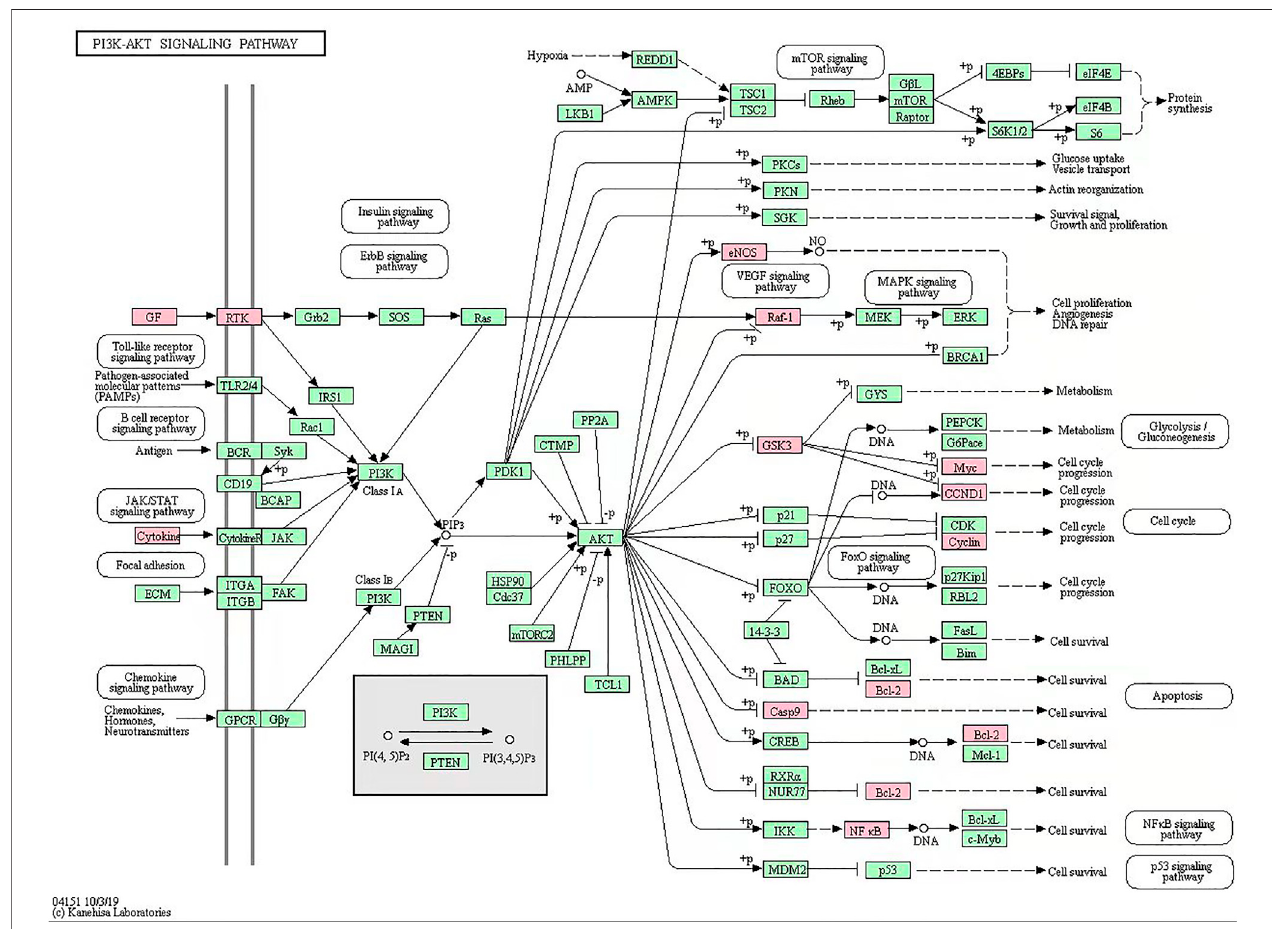
FIGURE 2 | Xihuang pills acts on potential target of PI3K-Akt signaling pathway. The green node represents a potential target for the action of Xihuang pills or an enzyme and compound associated with a potential target.